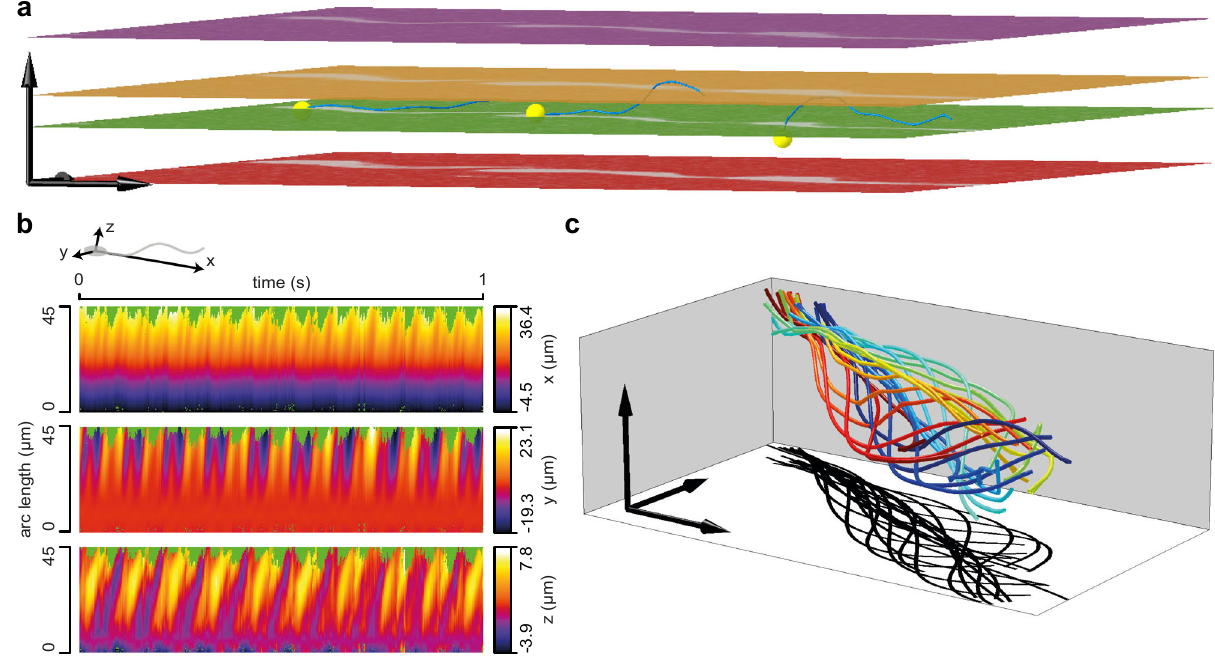
Fig. 4 3D reconstruction of the fl agellar beat from a swimming human sperm cell. a 3D visualization of the four planes (depicted in different colors) acquired by MFI and the fl agellum reconstructed using SpermQ-MF and the calibrated relationship between fl agellar width, position along the fl agellum, and z -distance to the respective plane (Fig. 3a). Overlay of three exemplary timepoints. Flagella indicated in blue. Positions of sperm heads indicated as yellow spheres. Arrows indicate 20 µ m. b Kymographic representation of fl agellar 3D coordinates (color-coded) in a reference system de fi ned by the head- midpiece axis (see sketch on top). For better visualization, only the fi rst second was plotted (reconstructed time span: 2.2 s). c 3D visualization of one beat cycle (time is color-coded). Arrows indicate 10 µ m. Shadow indicates a projection of the fl agellar beat to the xy -plane. Source Data are available as a source data fi